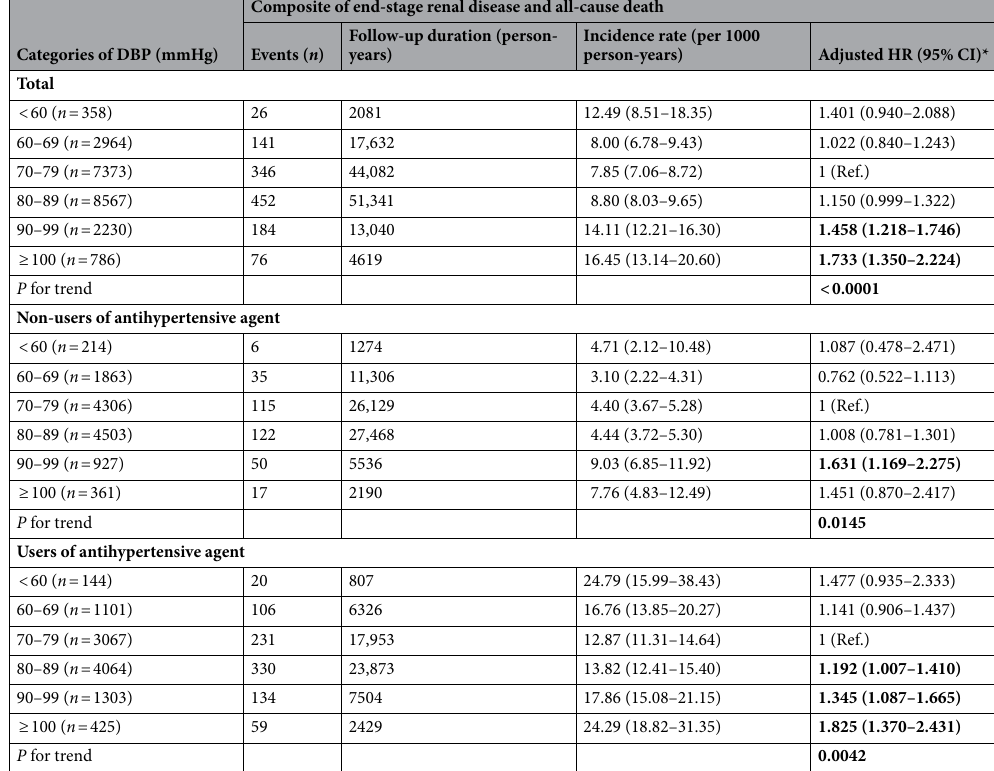
Table 3. Hazard ratios and 95% confidence intervals for the incidence of composite of end-stage renal disease and all-cause mortality according to the categories of diastolic blood pressure among the individuals with chronic kidney disease. DBP diastolic blood pressure, HR hazard ratio, CI confidence interval. *Adjusted for age, sex, current smoking, alcohol consumption, regular exercise, household income level, body mass index, presence of dyslipidaemia, diabetes mellitus, and urine dipstick positivity for protein. Adjusted HRs (95% CIs) and P-values, considered to be statistically significant in bold